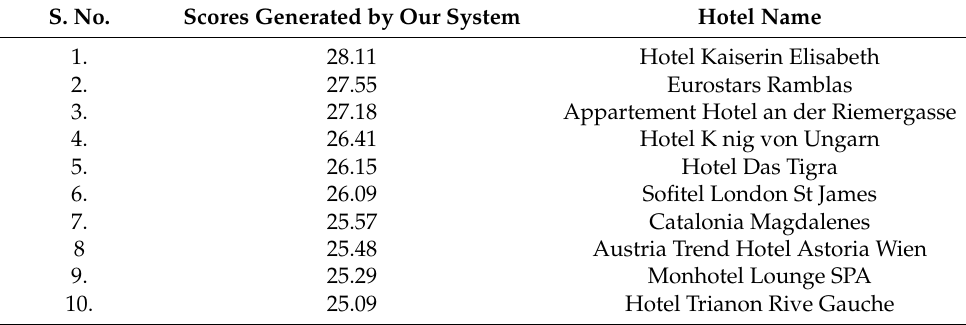
Table 11. Top-10 recommended hotels for the 1493 hotels of Booking by using our system. S.